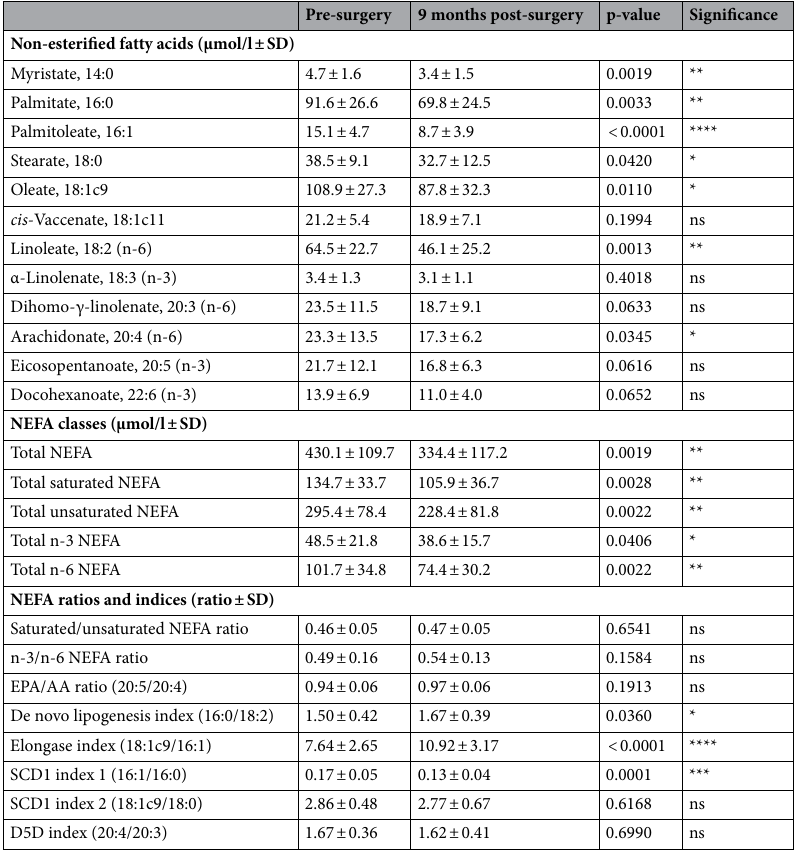
Table 3. Mean plasma NEFA concentrations and indices in participants before and 9 months after bariatric surgery. The p-values were calculated using paired T-test. Statistical significance is indicated as: ns not